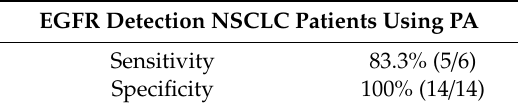
Table 4. Sensitivity and Specificity of EGFR Detection Using